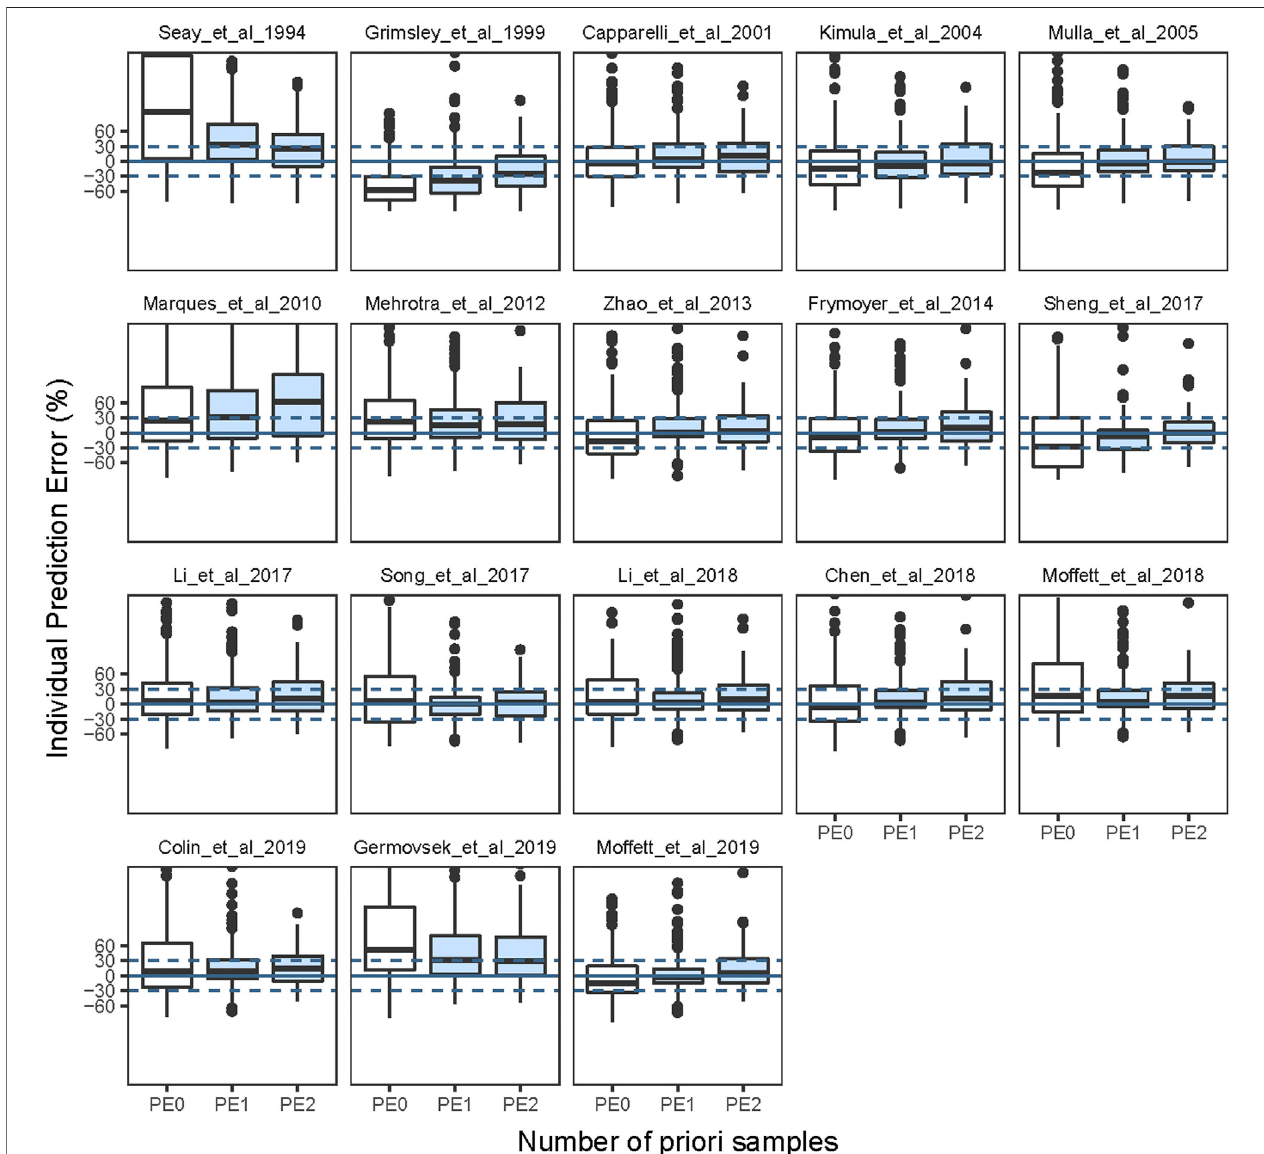
FIGURE 2 | Box plots of individual prediction error (IPE%) in external data with Bayesian forecasting for published population pharmacokinetic models in different scenarios (0 represents predictions without prior information and one to two represents with prior one to two observations, respectively).